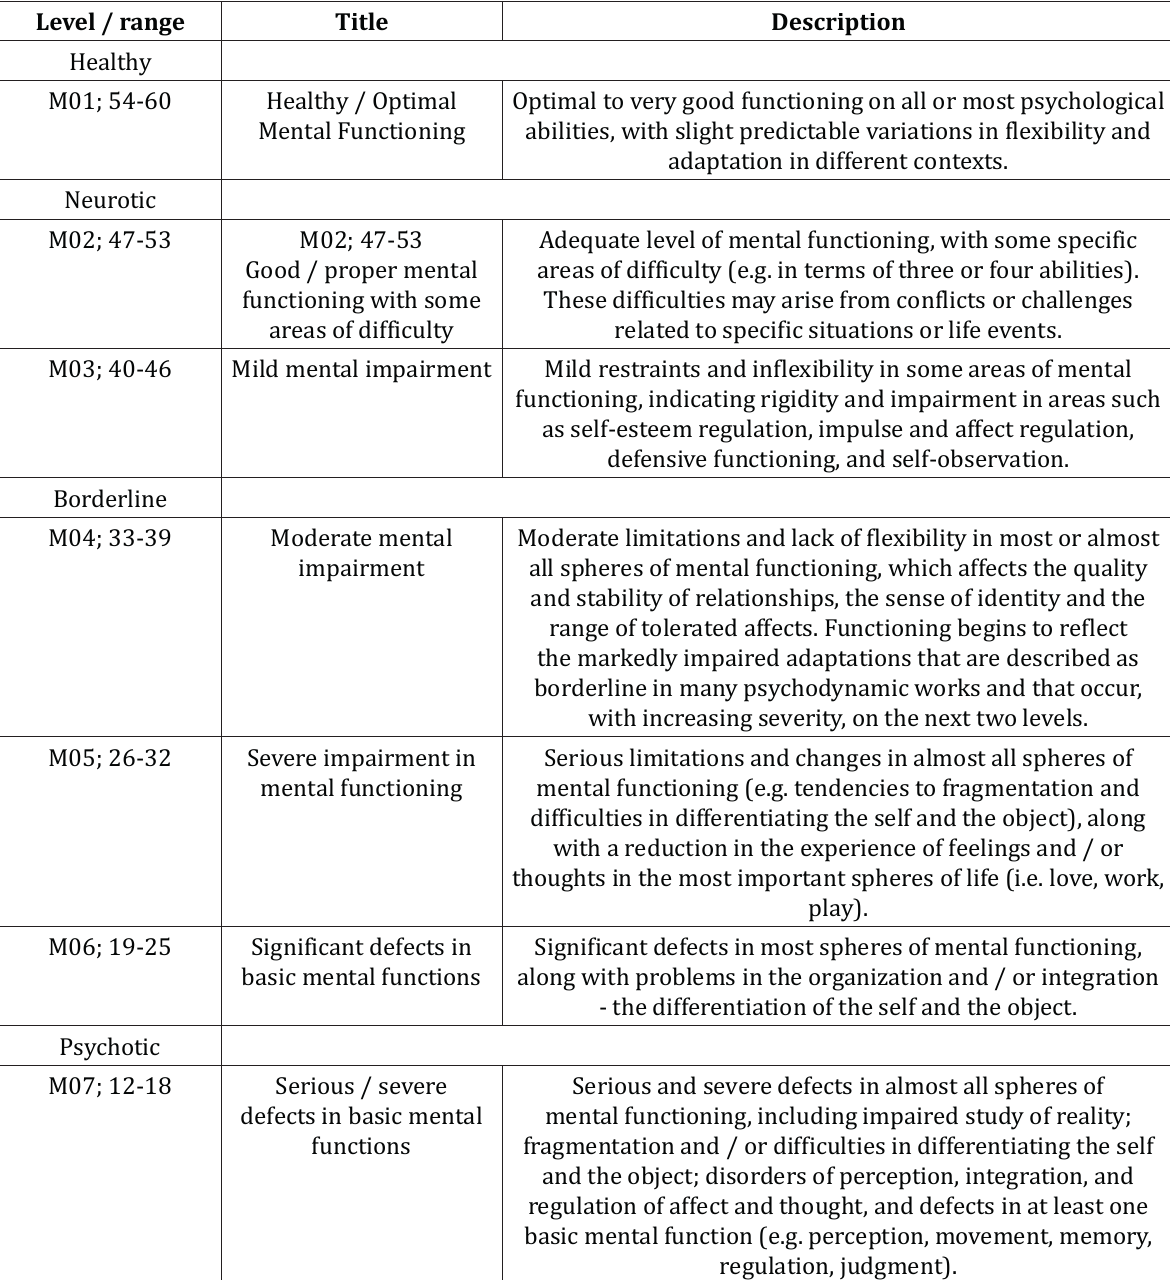
Table 3. M-axis capability level (source: [3]) Level / range Title